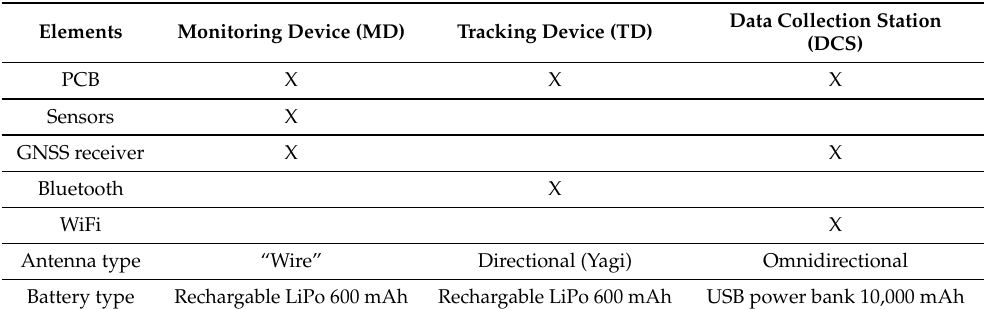
Table 1. List of components for each type of device of the family according to their functionalities. The "X" indicates the utilization of that